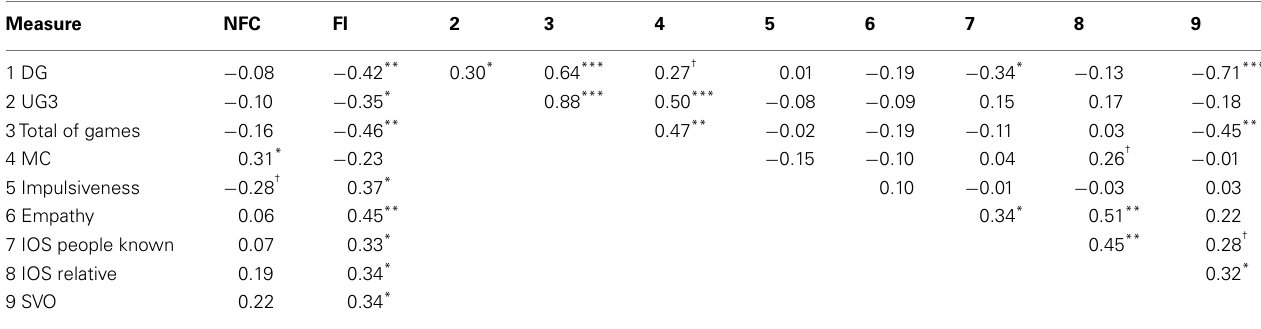
Table 2 | Non-parametric correlations of need for cognition and FI with the dependent variables of social cooperation and with the other questionnaire measures, and their